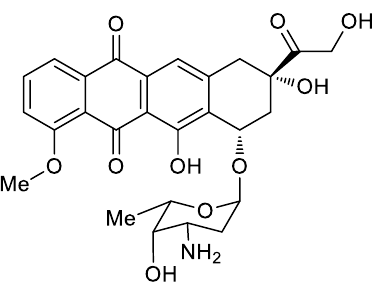
Figure 8. Structure of doxorubicin.